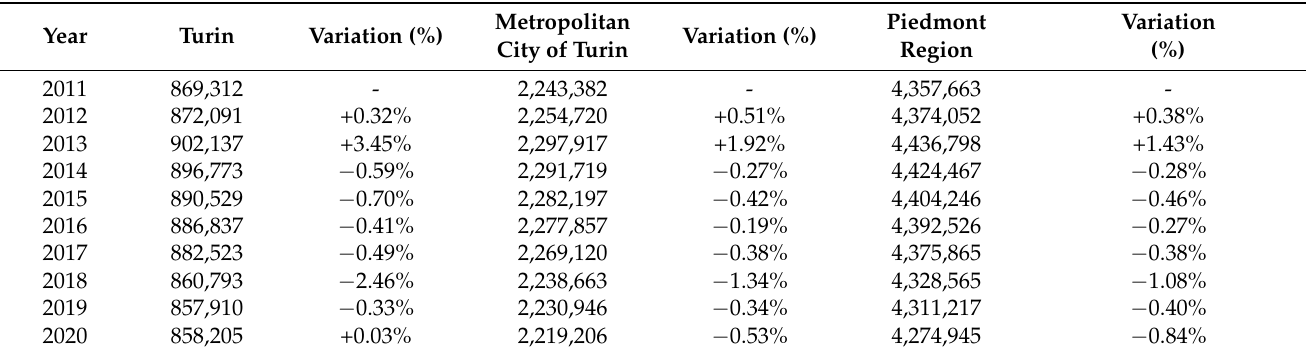
Table 5. Percentage changes in the resident population of the City of Turin, the Metropolitan City, and the Piedmont Region from 2011 to 2020